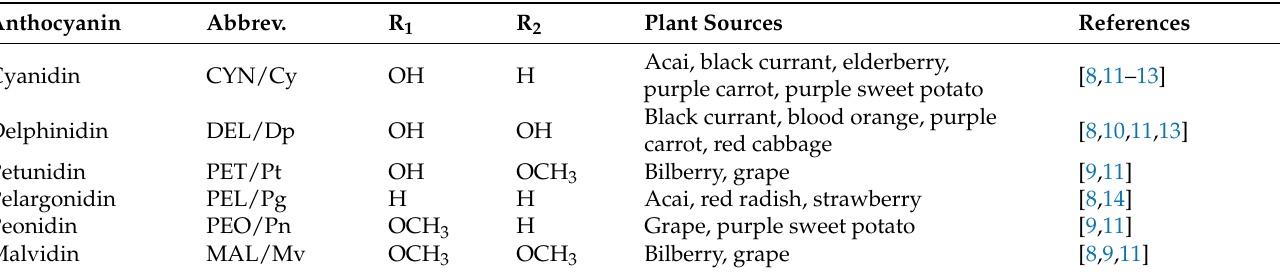
Figure 1. Structure of major anthocyanin-3-O-glucoside (R3). Table 1. Major anthocyanin structures and plant sources.